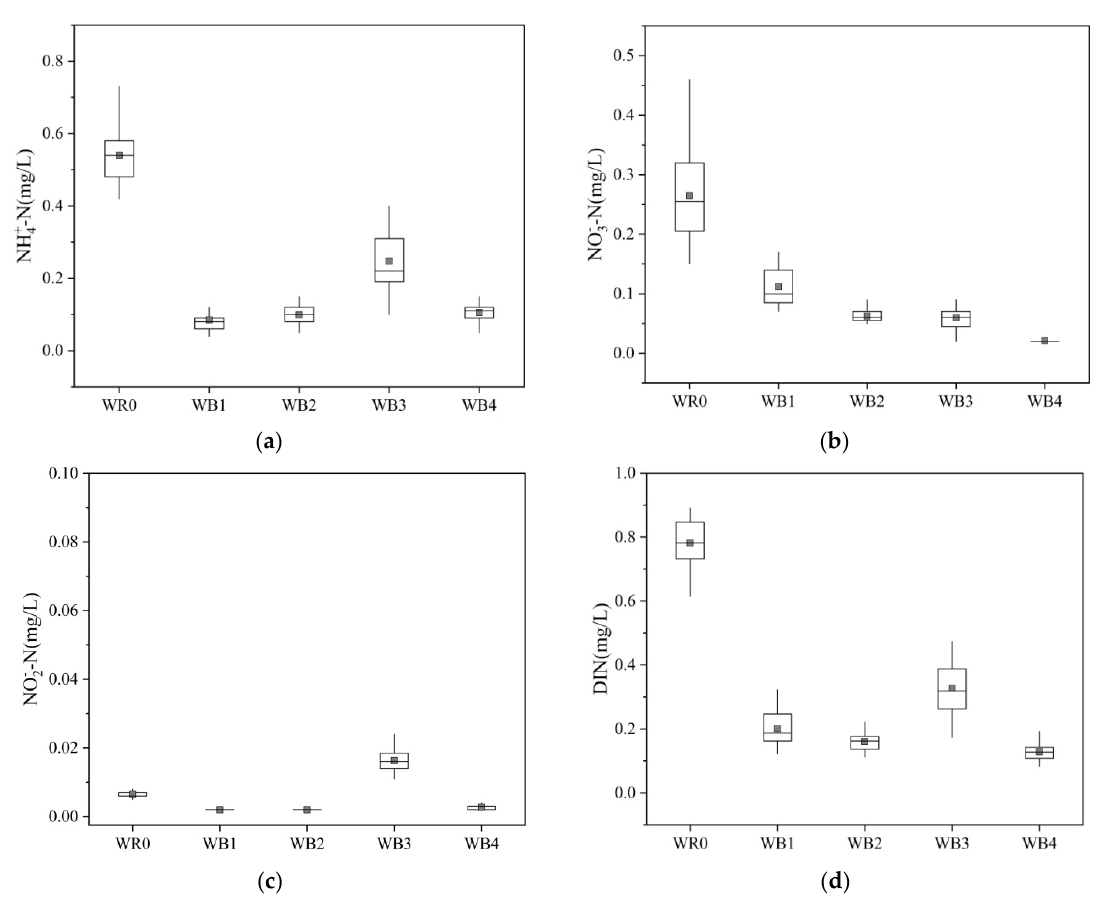
Figure 5. Boxplots of the observed concentrations of inorganic nitrogen in the river water and the riparian groundwater during the study period from 21 to 23 October 2021: ( a ) ammonia nitrogen, NH + ; ( b ) nitrate nitrogen, NO − ; ( c ) nitrite nitrogen, NO − ; ( d ) dissolved inorganic nitrogen, DIN. The mean NO − concentration was 0.265 mg/L in the river water and varied from 3